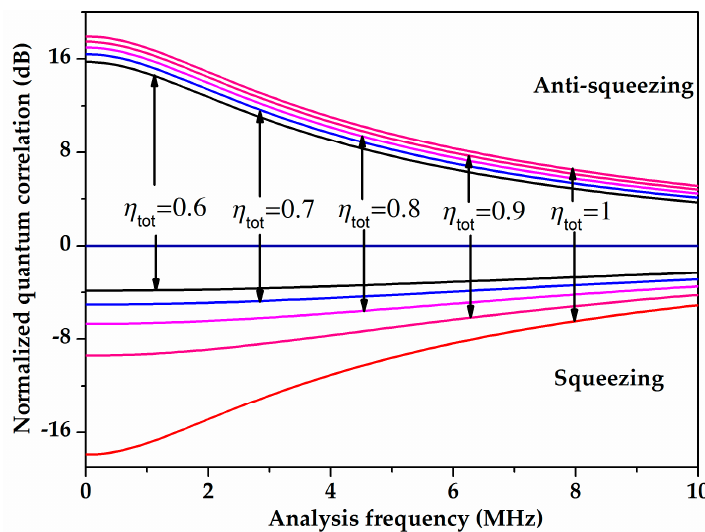
Figure 1. The simulated quantum correlation as a function of the analysis frequency with different total efficiencies. For all curves, (cid:3017) = 0.6, θ = 0, and f c = 17 MHz. The amount of detectable squeezing is not only limited by the optical loss, it is also limited by the fluctuations of the relative phase, which are always present in reality. Considering the phase jitter effects, the realistic squeezing V sq and anti-squeezing V Anti − sq are given by: